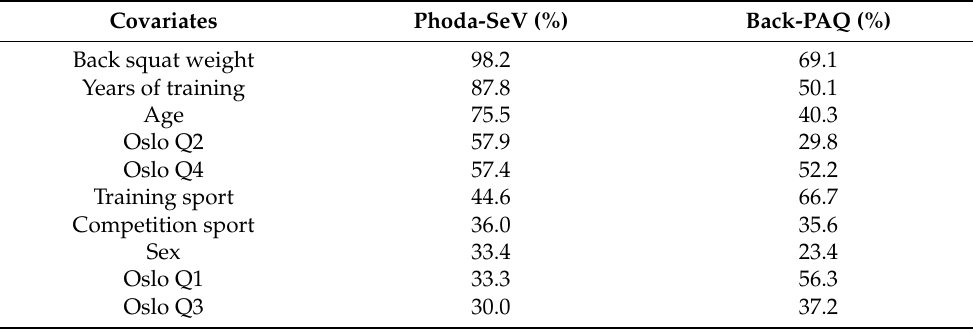
Table 4. Frequency of PHODA-SeV and Back-PAQ Covariates in Stability Analysis. Covariates Phoda-SeV